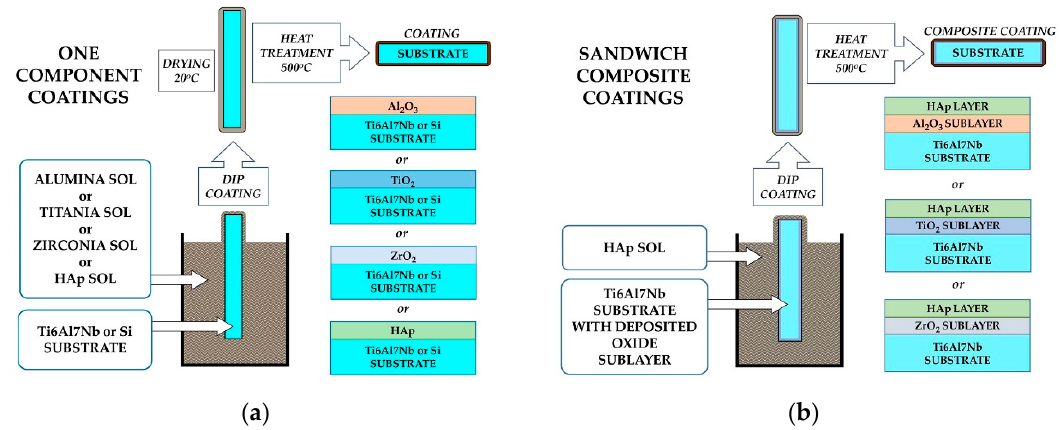
Figure 1. Manufacturing scheme of one component ( a ) and sandwich composite ( b ) coatings.